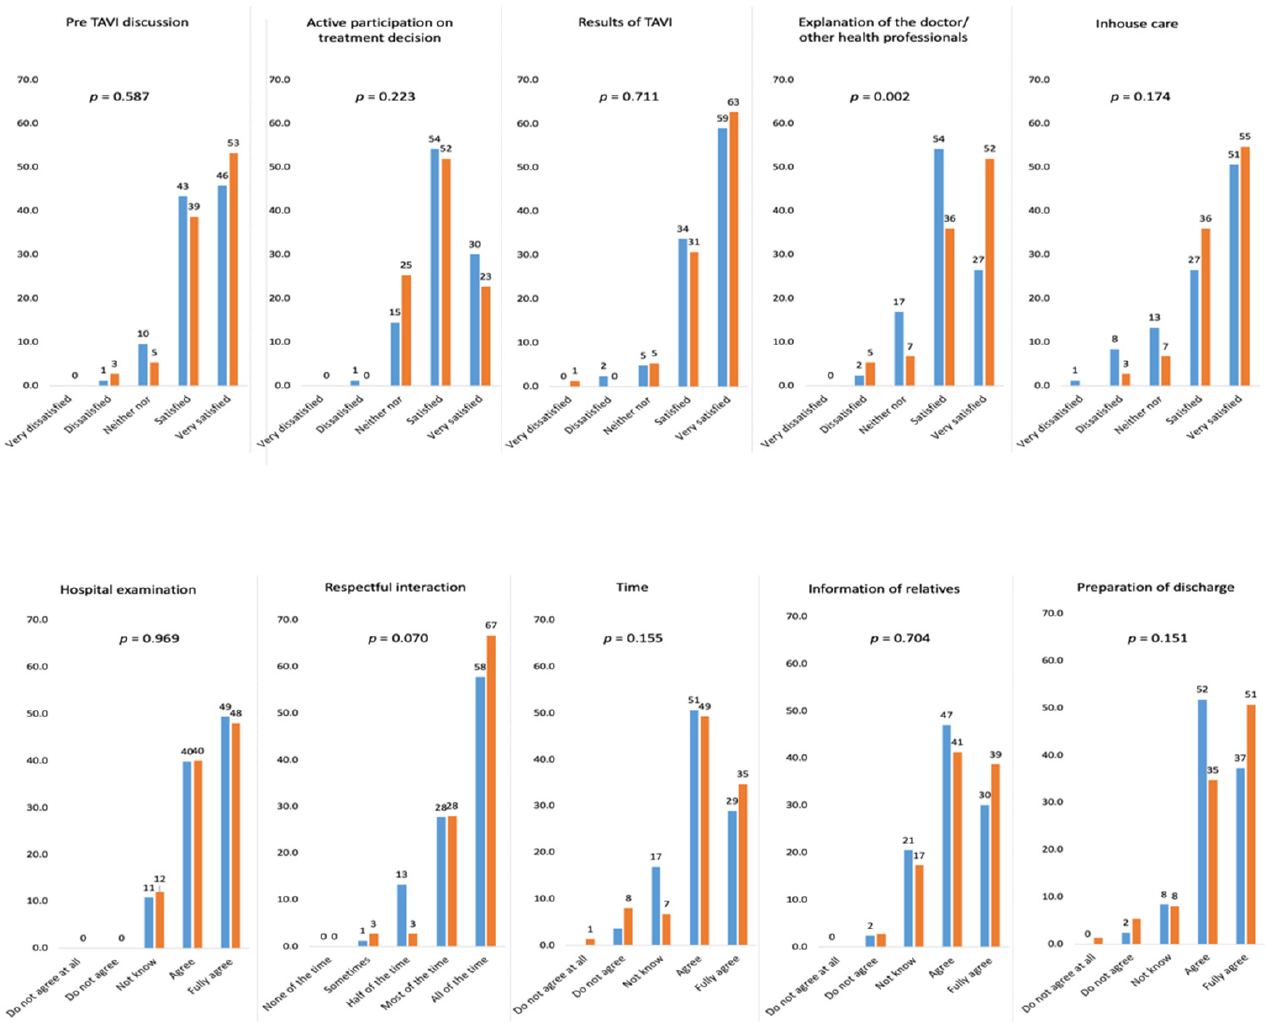
Figure 5. Patient satisfaction subcategories during control vs. intervention phases. Patient satisfac- tion was assessed using a 5-point scale where 0 = very dissatisfied and 5 = very satisfied (based on principles outlined by Hawthorne et al. [10] and modified to include questions on communication). TAVI, transcatheter aortic valve implantation. Blue-colored bars, control phase; orange-colored bars, intervention phase.